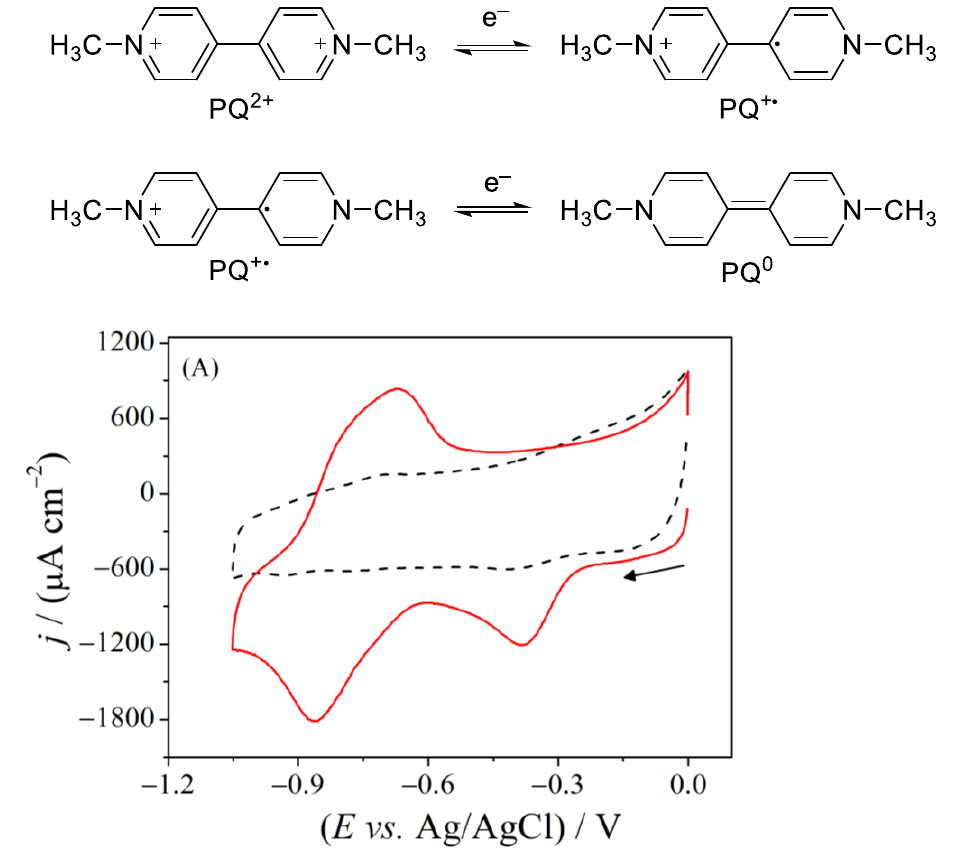
Figure 3. Cyclic voltammograms obtained using a paper-based silver sensor in the absence (black dashed line) and in the presence (red solid line) of 1.0 mmol L − 1 paraquat in 0.1 mol L − 1 Na 2 SO 4 , v = 100 mV s − 1